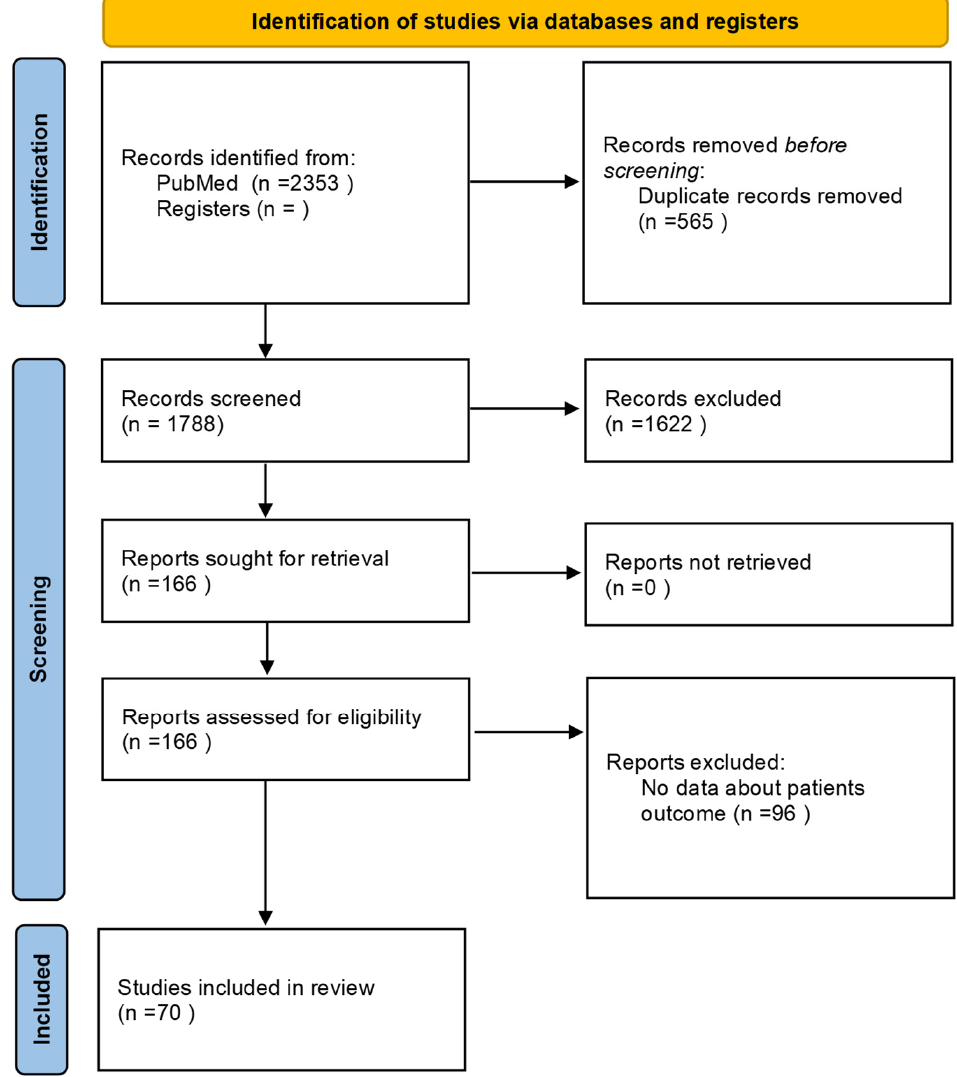
Figure 1. PRISMA flow diagram.